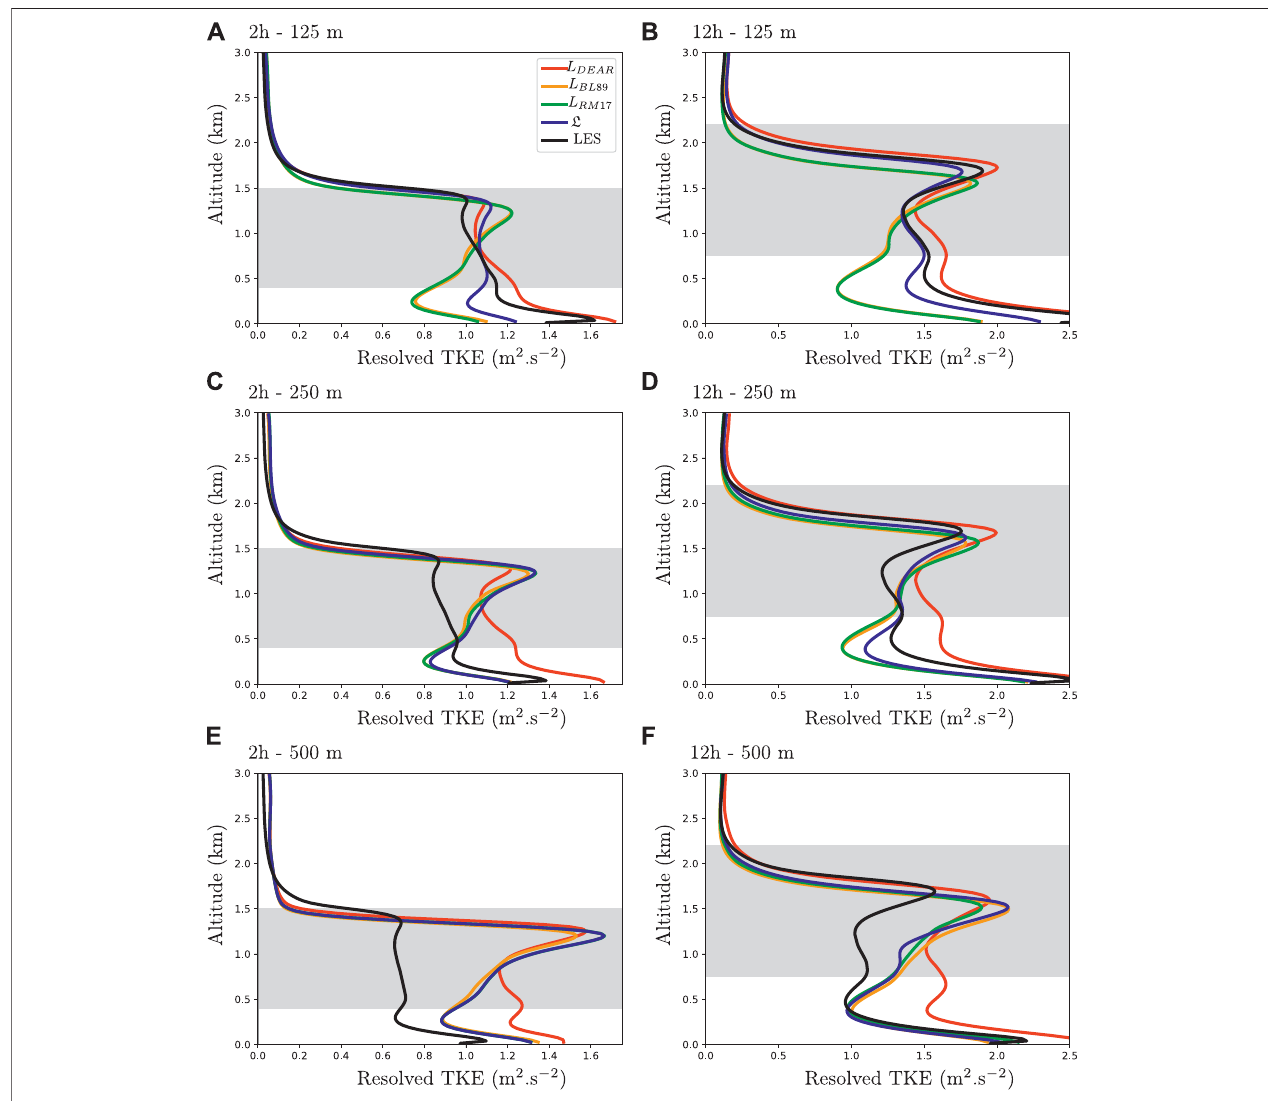
FIGURE 12 | Vertical pro fi les of TKE for CONSTRAIN simulations at 2 h (left column) and 12 h (right column) at the resolutions of 125 m (top row), 250 m (middle), 500 m (bottom row) with DEAR (in red), BL89 (in orange), RM17 (in green), L mixing length (in blue) and the reference LES coarse-graining (black).The gray area represents the cloud